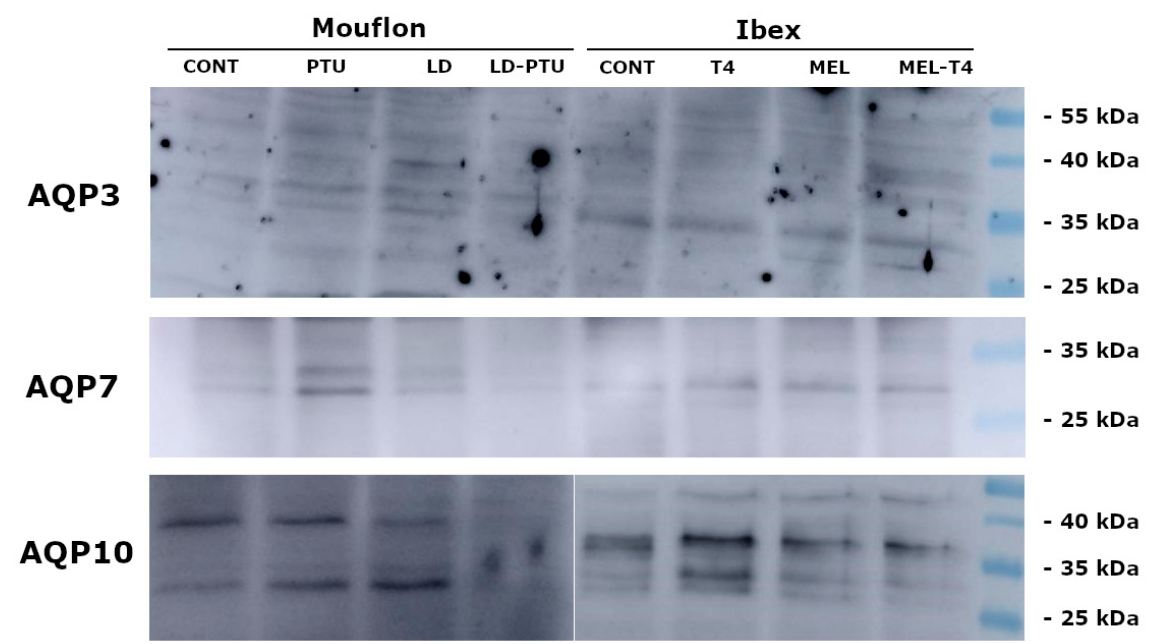
Figure 2. Western blot images showing expression patterns of AQP3, AQP7, and AQP10 in ibex sperm (controls treated with thyroxine (T4), treated with melatonin implants (MEL), treated with melatonin implants plus thyroxine (MEL+T4)), and mouflon sperm (controls administered propylthiouracil (PTU), exposed to long day photoperiod (LD), exposed to long day photoperiod plus PTU (LD+PTU)).